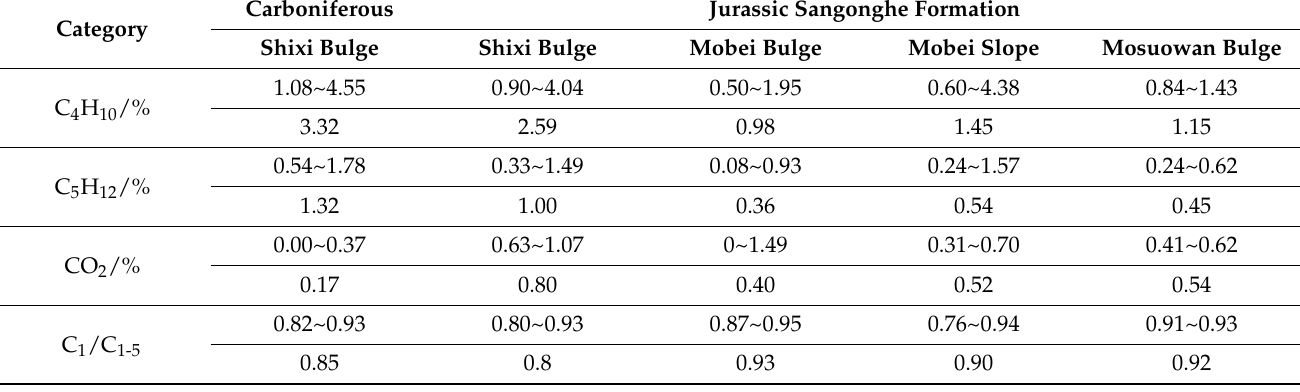
Figure 3. Cross-plots of δ 13 C 2 - δ 13 C 1 vs. δ 13 C 3 - δ 13 C 2 ( a ) and δ 13 C 3 - δ 13 C 2 vs. δ 13 C 4 - δ 13 C 3 ( b ) of the natural gas in the eastern belt around the Penyijingxi sag, Junggar Basin. SXB C means the Carboniferous system of Shixi bulge, SXB J1s means Jurassic Sangonghe formation of Shixi bulge, MBB J1s means Jurassic Sangonghe formation of Mobei bulge, MBS J1s means Jurassic Sangonghe formation of Mobei slope, MSWB J1s means Jurassic Sangonghe formation of Mosuowan bulge. 5. Discussion 5.1. Genesis types of the Natural Gas The carbon isotopic compositions of methane and ethane and the carbon isotopic se- ries of their homologues are important indicators to identify whether the alkane gases are of inorganic or organic origin, and are commonly used to determine the genesis of natural gas [7]. The alkane gases in the natural gases from the Shixi, Mobei, and Mosuowan bulges and the Mobei slope have a positive carbon isotopic series ( δ 13 C 1 < δ 13 C 2 < δ 13 C 3 ) that is reversed for butane (Figure 3). This partial reversal may be due to the mixing of natural gases of different genesis, migration, or secondary changes [11,12]. Primary alkane gases should have a positive carbon isotopic series ( δ 13 C 1 < δ C 132 < δ 13 C 3 < δ 13 C 4 ). In addition, while the isotopic composition of methane of inorganic origin is generally greater than − 30‰, this value of the gases in the studied area is less than − 30‰ (Figure 4). Therefore, it can be concluded that the natural gases in the eastern belt around the Penyijingxi sag